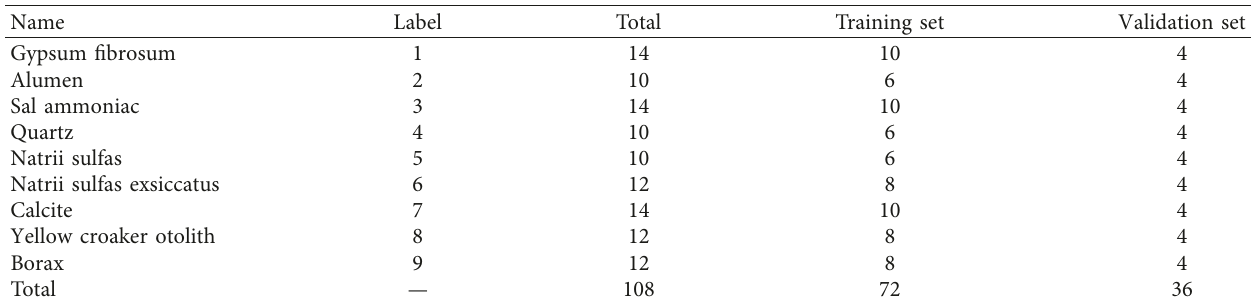
Table 3: Sample sets.